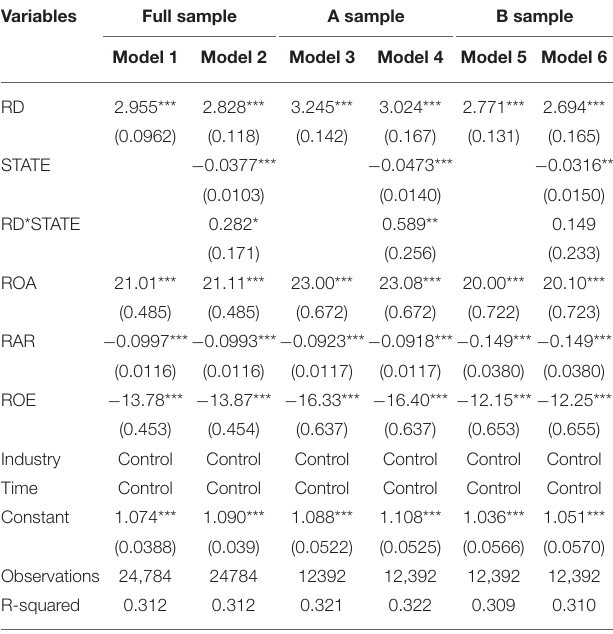
TABLE 2 | Regression results of R&D investment.